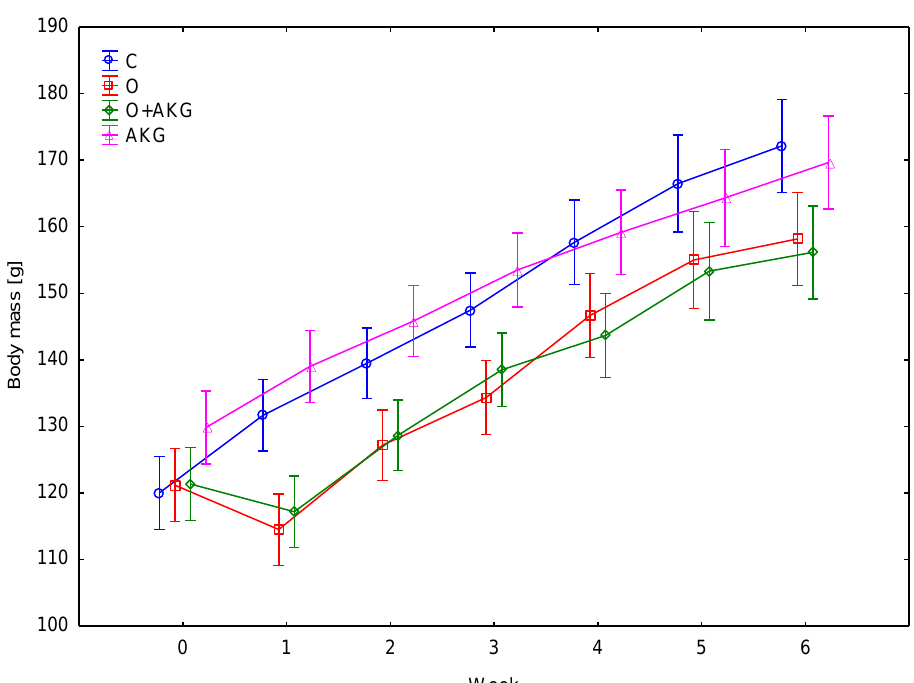
Figure 1. Effect of bariatric surgery and administration of alpha-ketoglutarate (AKG) on body weight in rats. C — control, O — gastric bypass surgery, O + AKG — gastric bypass surgery and administration of alpha-ketoglutarate, AKG — administration of alpha-ketoglutarate. Alpha-ketoglutarate (0.2 g/kg/body mass/day) was administered in the drinking water.